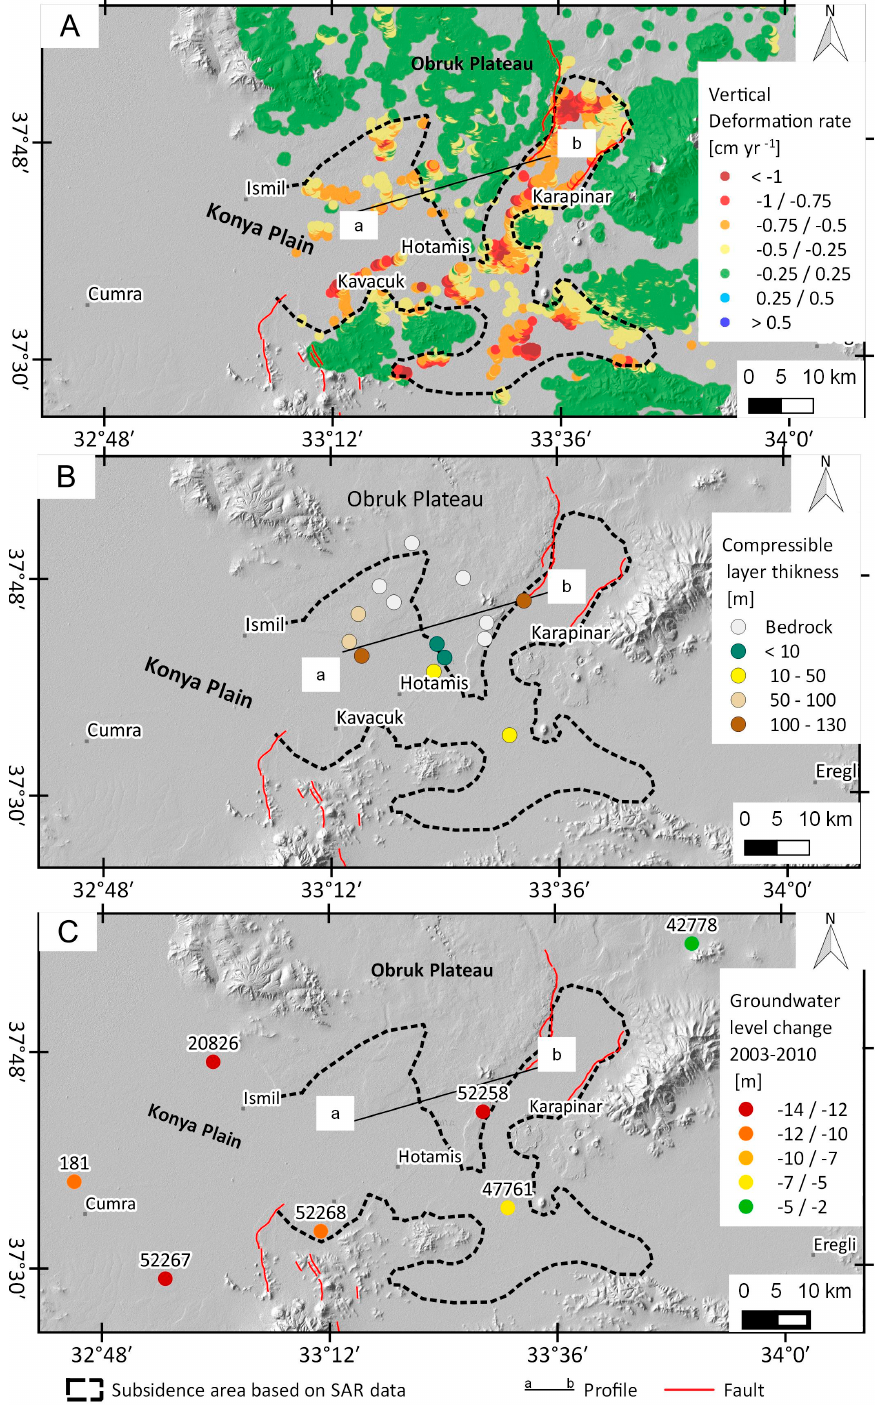
Figure 9. ( A ) Subsidence area revealed by the SBAS-DInSAR analysis; ( B ) Thickness of compressible layers (i.e., clay and silt) from the available cores. Location of the a-b geological profile reported in Figure 10 is also shown; ( C ) Groundwater level changes measured in the available wells.